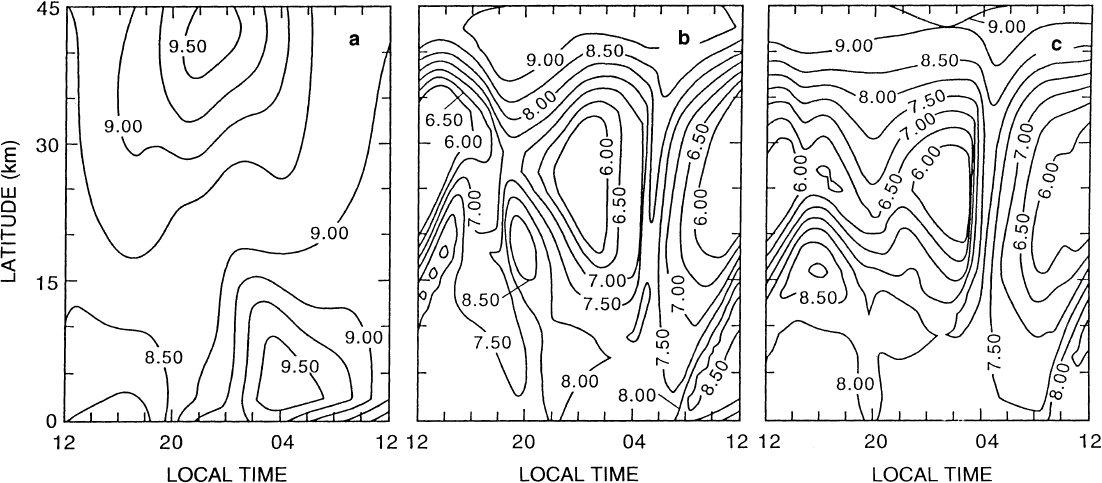
Fig. 12a–c. Same as Fig. 8, except due to transport by zonal and meridional winds and